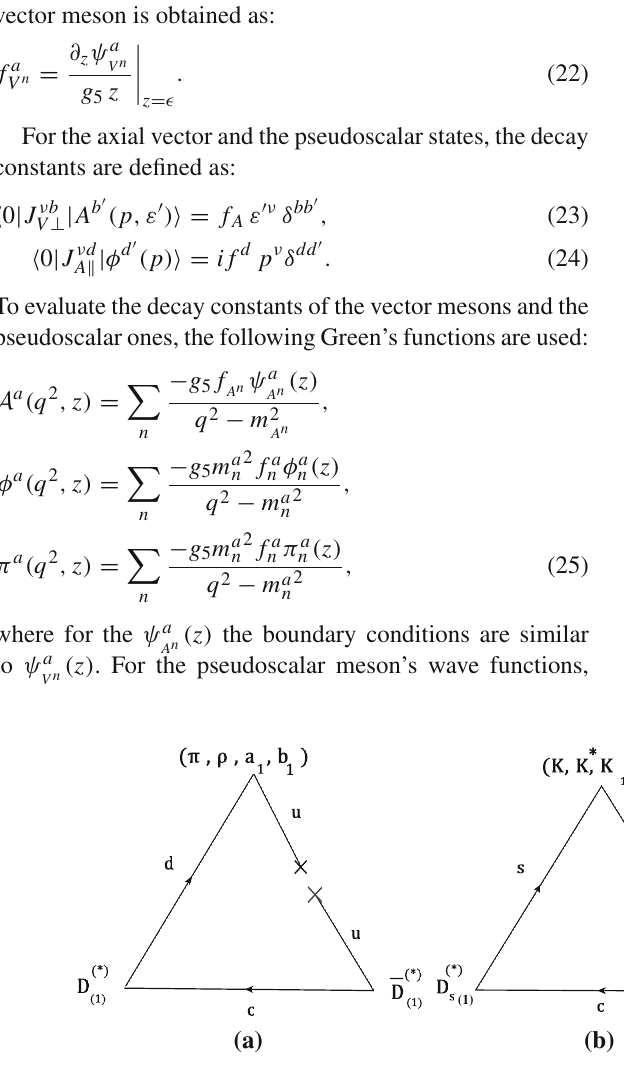
Fig. 1 3-particle diagrams show ( D ( ∗ ) , D , A ) , ( D ( ∗ ) , D ( ∗ ) , V ) and ( D , D , P ) vertices. Diagram a describes ( D − ( ∗− ) , ¯ D 0 , a − 1 1